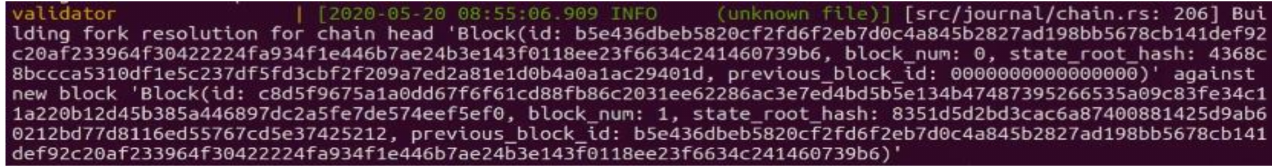
Figure 6. Web-based blockchain Sawtooth-enabled renewable energy and power chain of node interface.